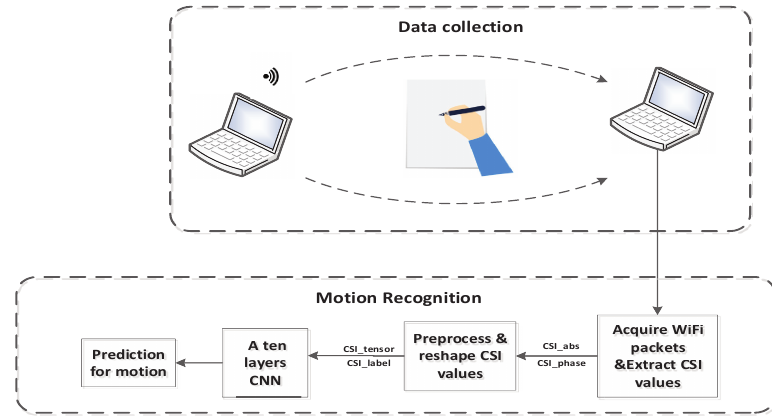
Figure 1. Overview structure of MCSM-Wri. CNN = convolutional neural network; CSI = channel state